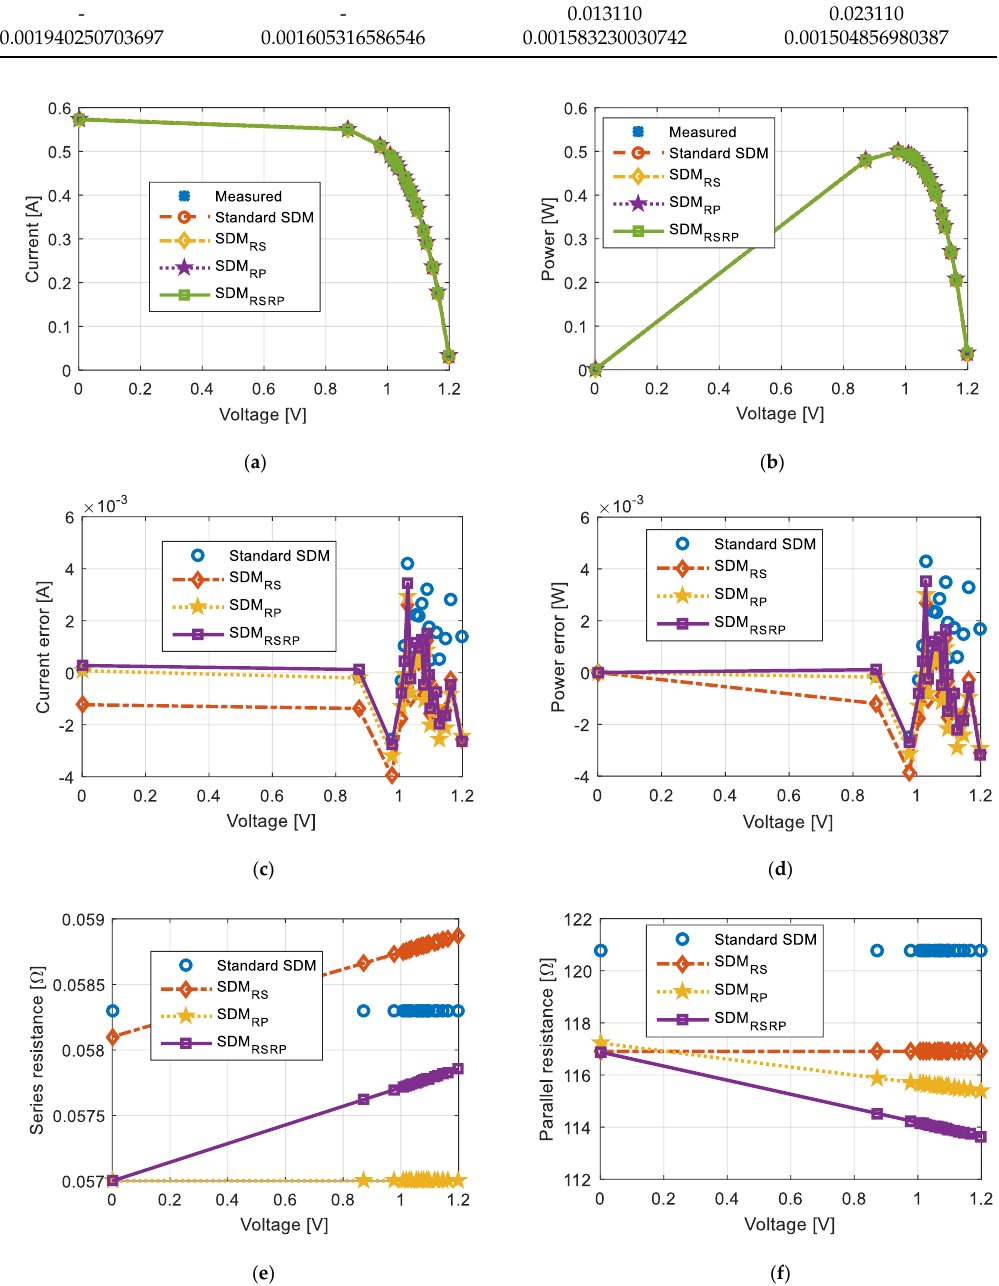
Figure 13. Solar laboratory module: ( a ) current-voltage characteristics; ( b ) power-voltage characteristics; ( c ) corresponding current-voltage errors; ( d ) corresponding power-voltage errors; ( e ) series resistance – voltage dependence characteristics; ( f ) parallel resistance – voltage dependence characteristics.